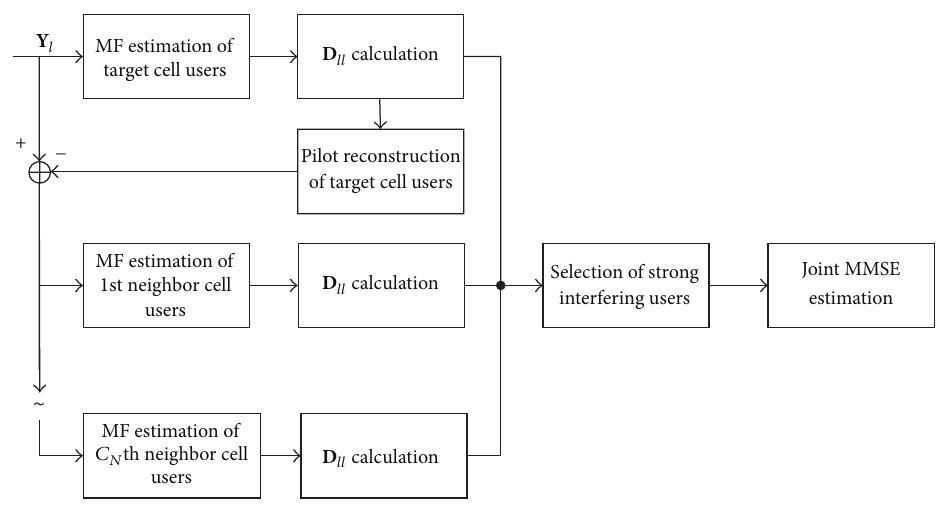
Figure 2: Block diagram for an improved joint MMSE channel estimation.